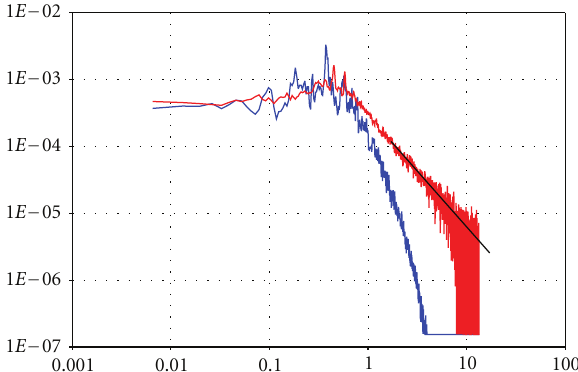
Figure 14: Energy spectrum of the radial velocity fluctuations in the free vortex ( z ∗ = 0 . 35 and r ∗ = 0 . 89). Red line: experiments; blue lines: LES computations. The black straight line is a k − 5 / 3 slope.